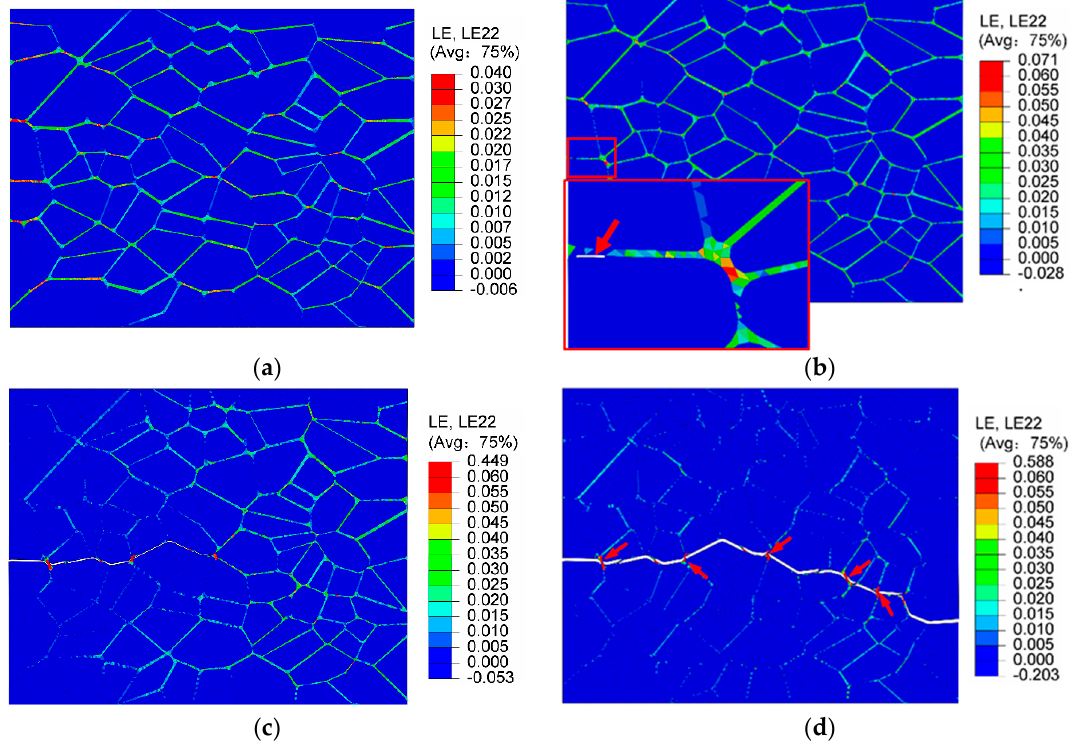
ε and failure evolution at macroscopic y